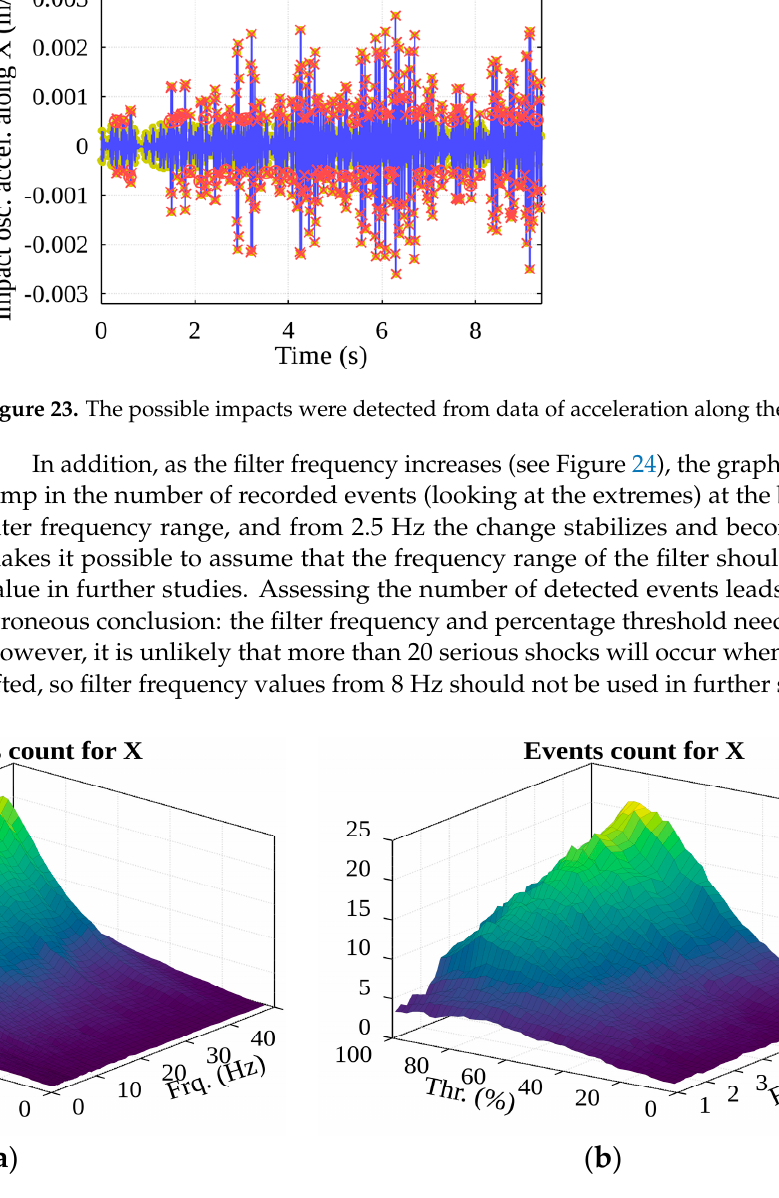
Figure 22. The surface of potential events X f (in the ( a )—1–49 Hz; ( b )—1–8 Hz frequency range). Looking at the number of detected events (see Figure 23), it can be observed that the number of groups of potential events increase as the filter frequency increases. This can be attributed to the fact that, as the frequency increases, the oscillation amplitude of the filtered acceleration decreases and the oscillation bursts increase, meaning the chances of forming more groups is potentially higher .